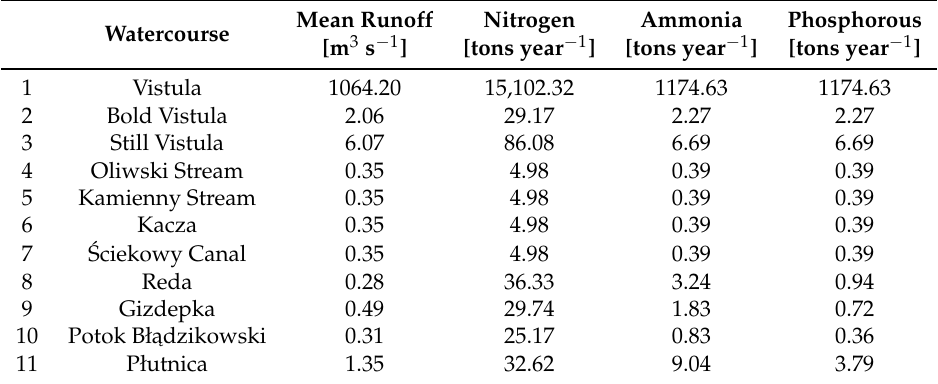
Table 2. The river runoff into the Baltic Sea in 2016 inside the model domain